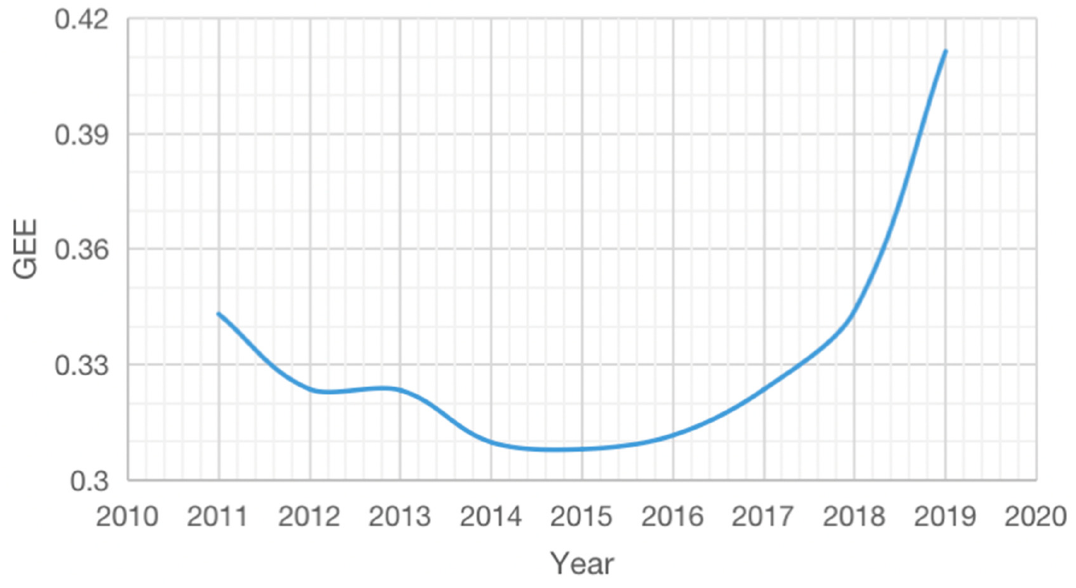
Figure 2. The average value change trend of GEE from 2011 to 2019.